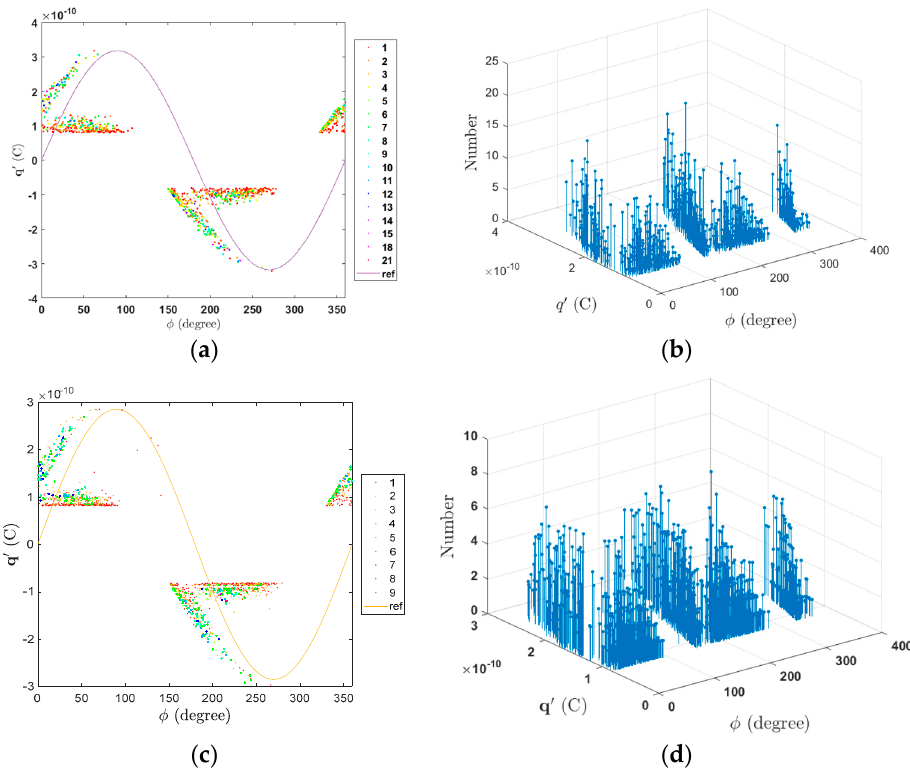
Figure 8. q- φ -n diagrams for the case study: ( a ) 2D representation of the q- φ -n diagram using the Figure 8. q- ϕ -n diagrams for the case study: ( a ) 2D representation of the q- ϕ -n diagram using the analytical model; ( b ) 3D representation of the q- ϕ -n diagram using the analytical model; ( c ) 2D analytical model; ( b ) 3D representation of the q- φ -n diagram using the analytical model; ( c ) 2D representation of the q- ϕ -n diagram using the three capacitance model; ( d ) 3D representation of the q- ϕ -n diagram using the three capacitance